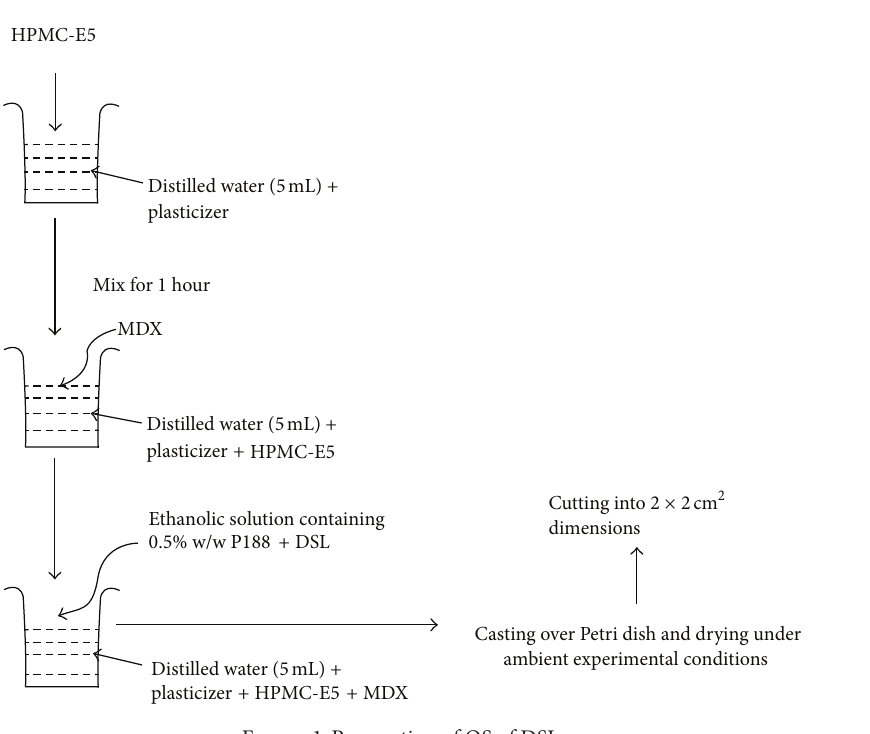
Figure 1: Preparation of OS of